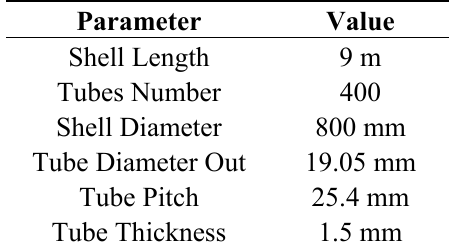
Table 5. Geometrical features of the regenerator.